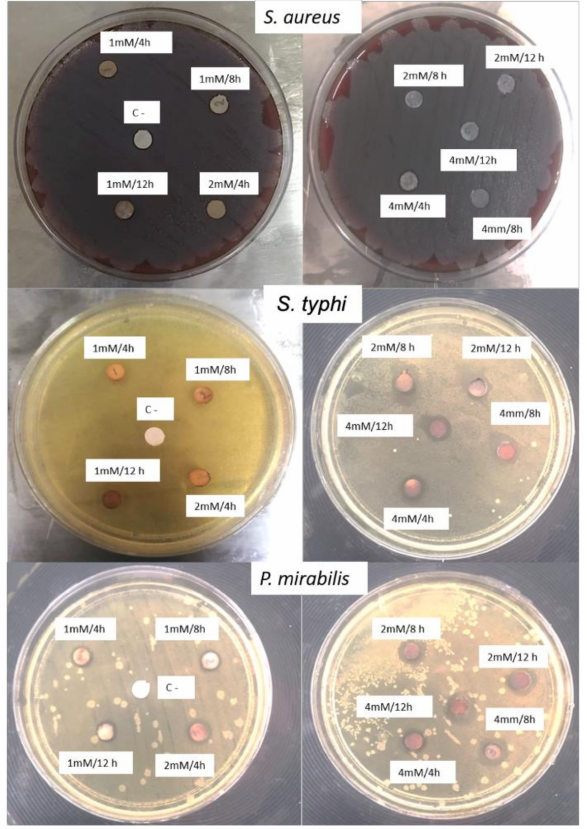
Figure 6. Inhibition zone of S. typhi bacteria in Mueller Hinton Agar with AgNPs obtained at different reaction